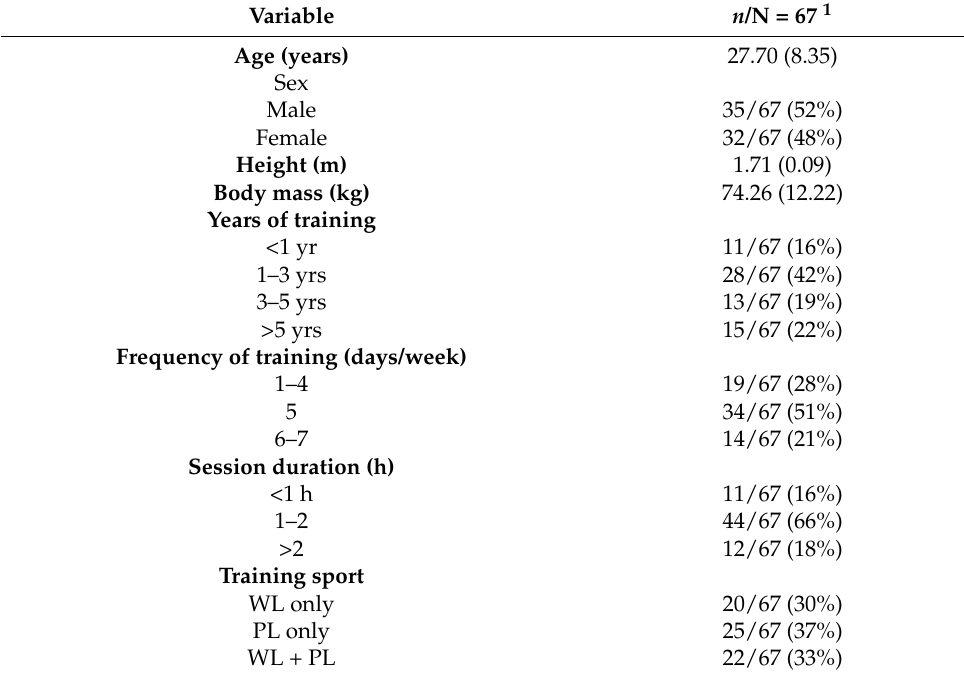
Table 1. Descriptive Statistics for